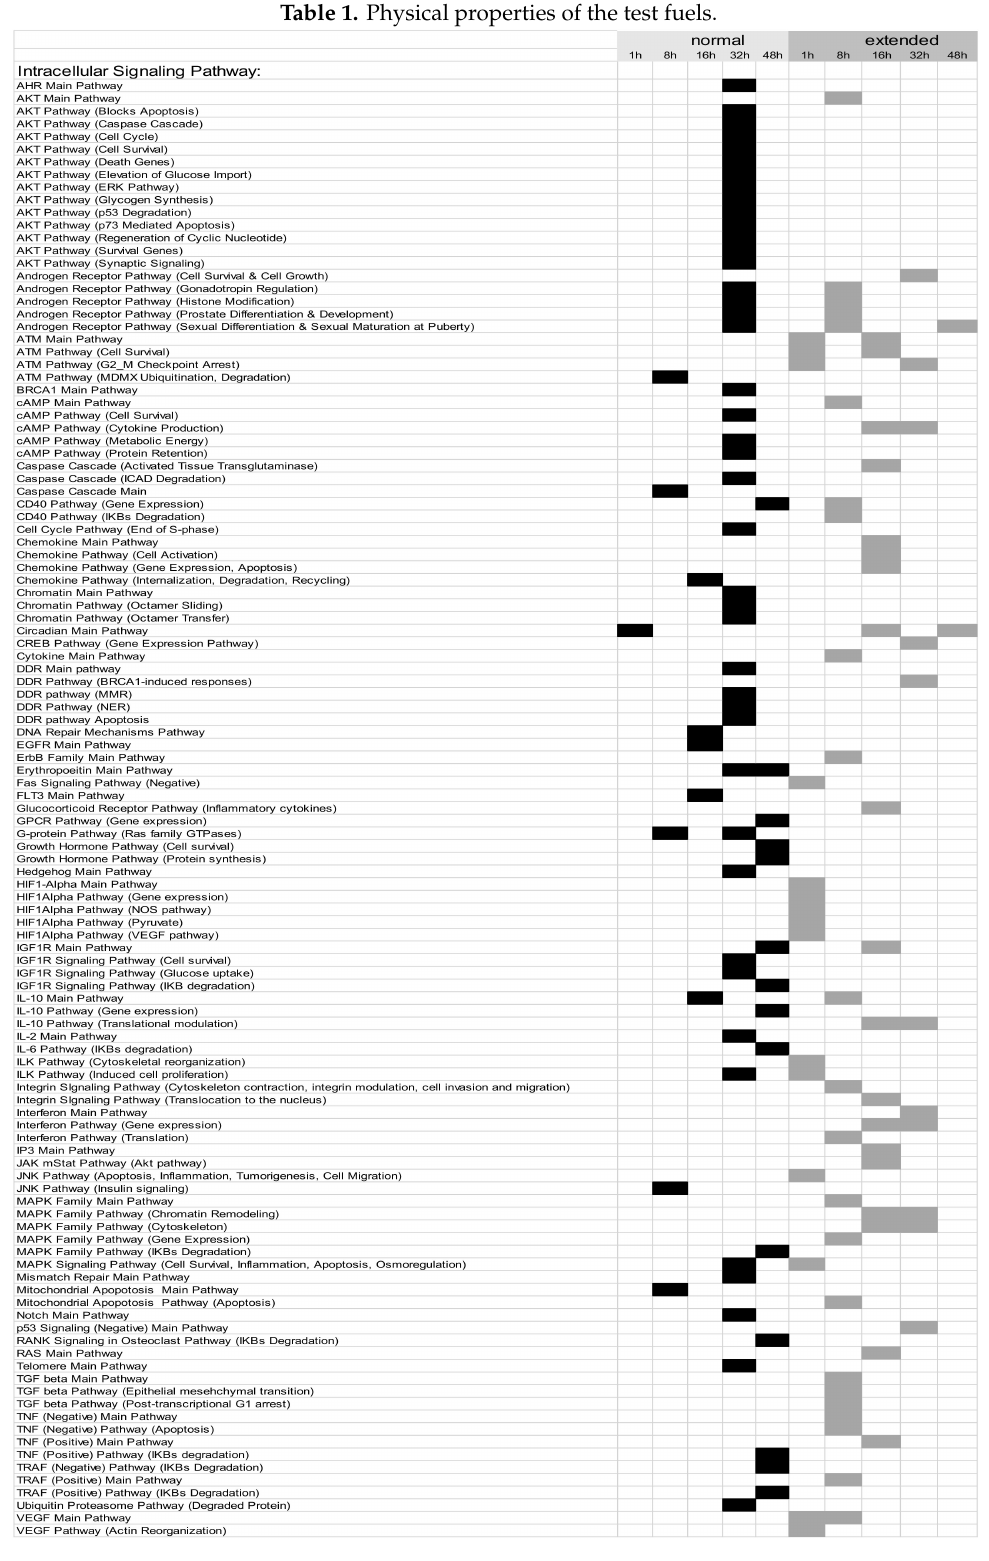
Table 1. Physical properties of the test